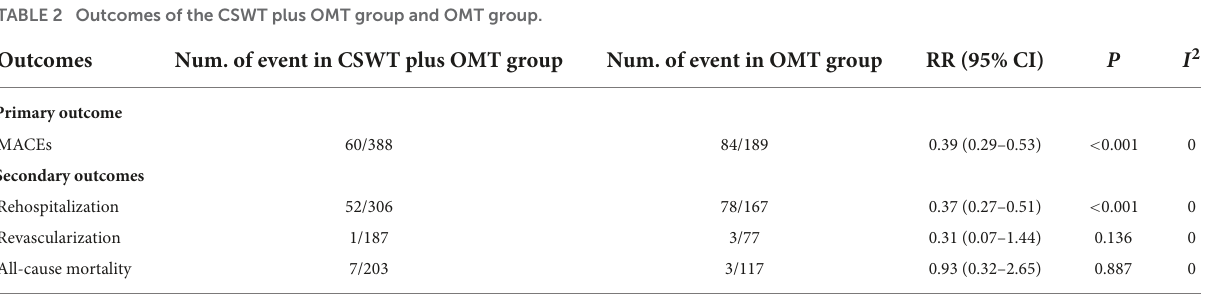
TABLE 2 Outcomes of the CSWT plus OMT group and OMT